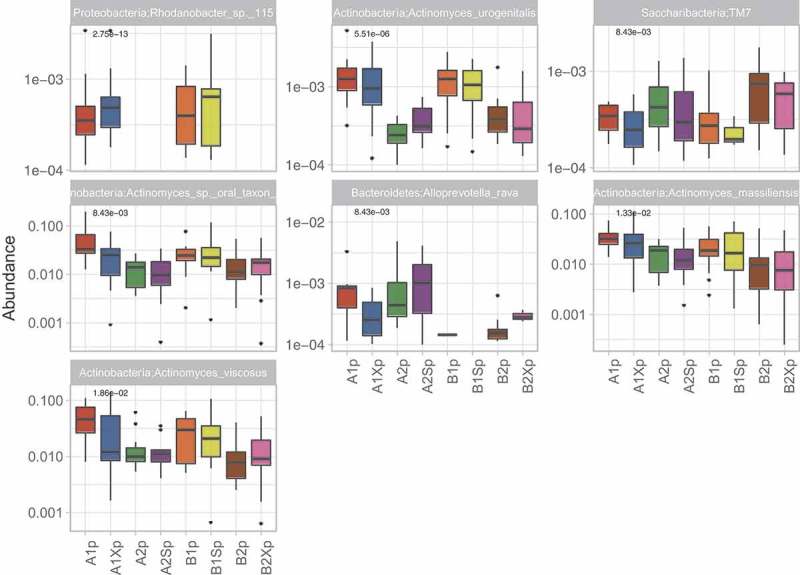
Species that showed significant differences in abundance (p < 0.05) among plaque samples collected from Group A and B at different time points.